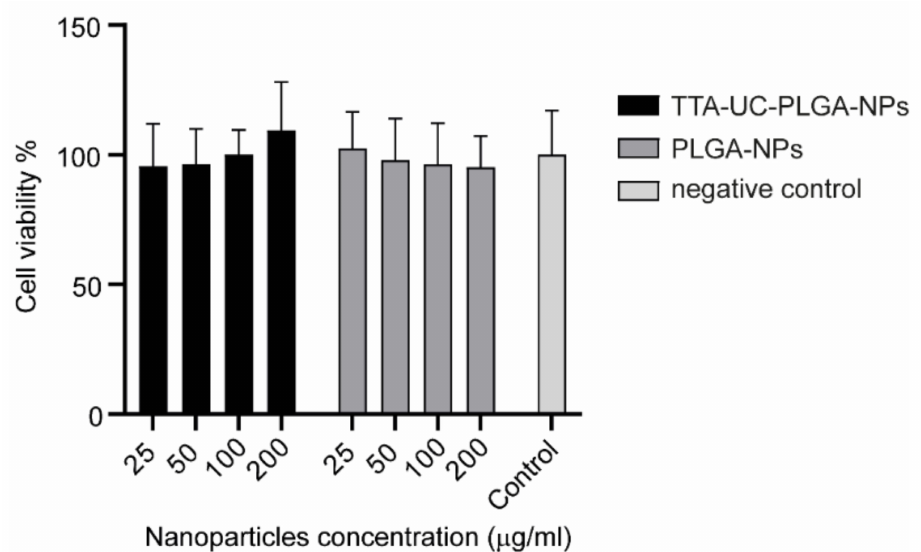
Figure 4. Assessment of cellular cytotoxicity of TTA-UC-PLGA-NPs. OVCAR-3 cells were incubated with 25, 50, 100 and 200 µ g/mL TTA-UC-PLGA-NPs or control PLGA-NPs for 72 h. Untreated cells were used as negative control. The cell viability was assessed after 72 h by MTS assay.